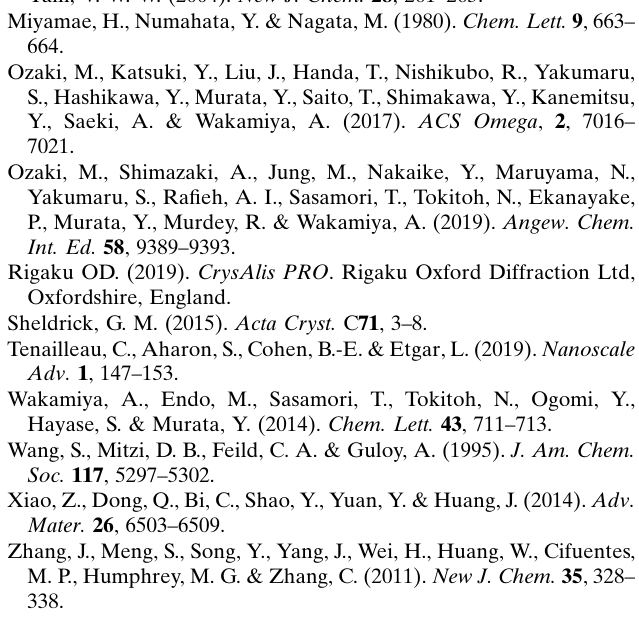
Data collection